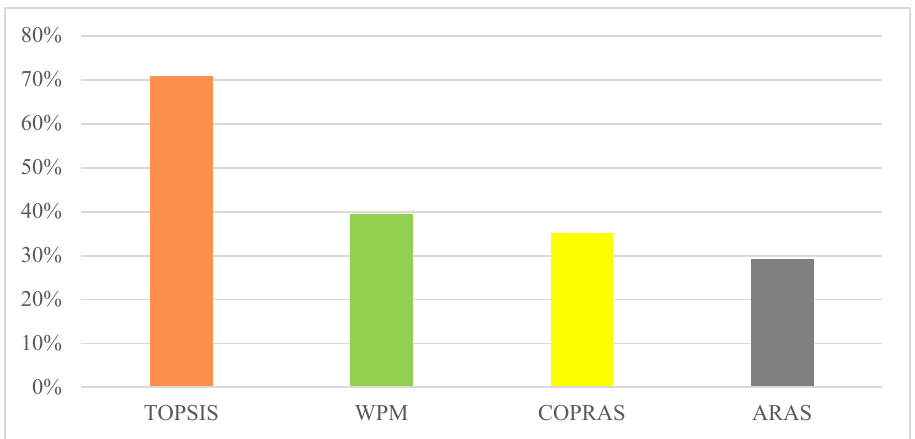
Figure 5. The similarities of performance between the IVEP method and other MCDM methods computed by the Zakeri–Konstantas performance correlation coefficient.